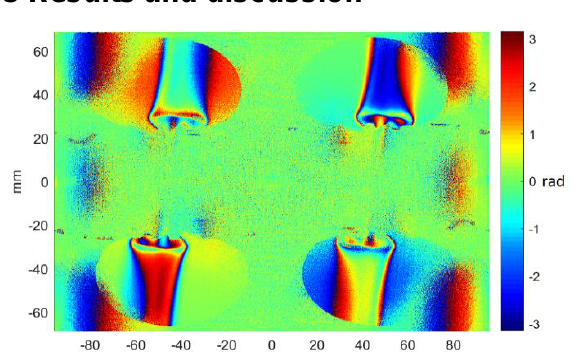
Fig.3. Reconstructed phase field map at some time instant. Fig.3. represents the reconstructed phase field